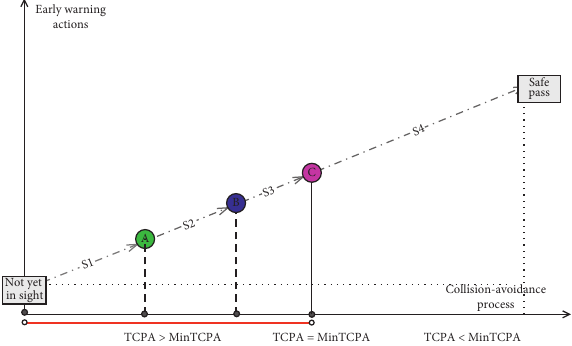
Figure 6: Demonstration of early warning method of inland ship collision risk based on coordinated collision-avoidance actions. A: understanding each other’s movements. B: unifying collision- avoidance strategies. C: taking coordinated maneuvering actions. S1: not yet understanding each other’s movements. S2: not yet unifying collision-avoidance strategies. S3: not yet taking coordi- nated maneuver’s actions. S4: verifying collision-avoidance effec- tiveness. TCPA: time to the closest point of